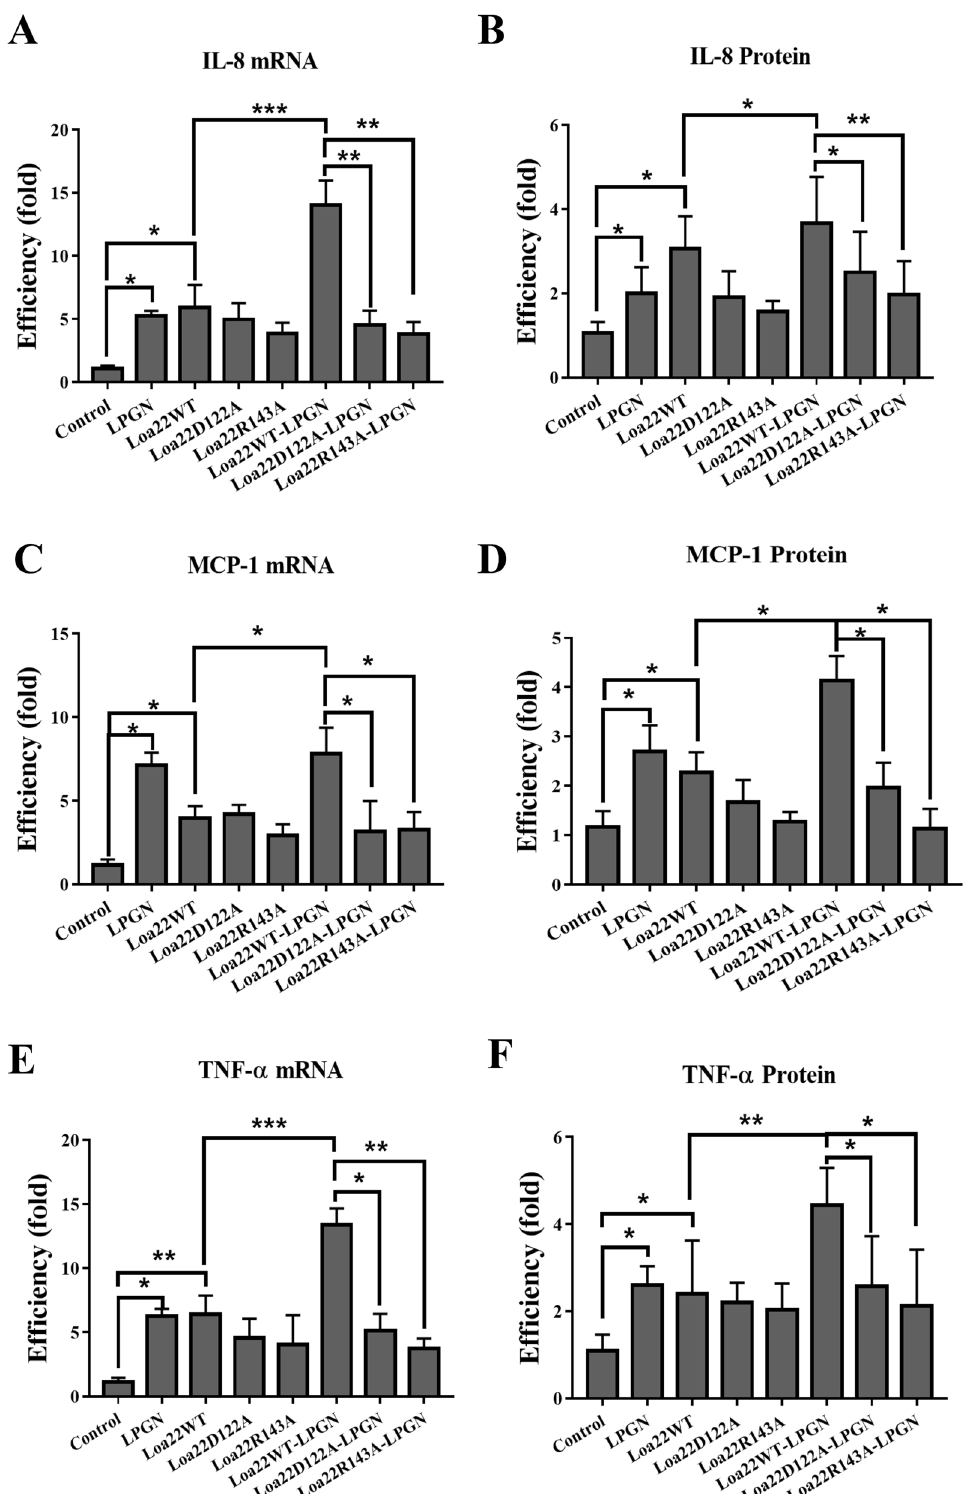
Figure 6. Inflammatory responses induced by rLoa22-LPGN in HEK293-TLR2 cells. HEK293-TLR2 cells were cultured to 70% confluence and changed to serum free conditions for 16 h. The stimulation agents (0.1 μg/ml) were added to stimulate the downstream inflammatory responses from TLR2 signaling such as CXCL8/IL8 , hCCL2/MCP-1 , and hTNF-α . ( A ) Stimulation of the expression of CXCL8/IL8 mRNA. ( B ) Stimulation of the expression of CXCL8/IL8 protein. ( C ) Stimulation of the expression of hCCL2/MCP-1 mRNA. ( D ) Stimulation of the expression of hCCL2/MCP-1 protein ( E ) Stimulation of the expression of hTNF-α mRNA. ( F ) Stimulation of the expression of hTNF-α protein. Inflammatory responses stimulated by Loa22 and its variants (rLoa22WT, rLoa22D122A, and rLoa22R143A) in the presence or absence of LPGN. The results of mRNA levels in different genes are displayed as the transcript levels of the analyzed genes relative to GAPDH (glyceraldehyde- 3-phosphate dehydrogenase) transcript level. The secretion cytokines were measured by ELISA. ⃰ p < 0.05; ⃰ ⃰ p < 0.01; ⃰ ⃰ ⃰ p <